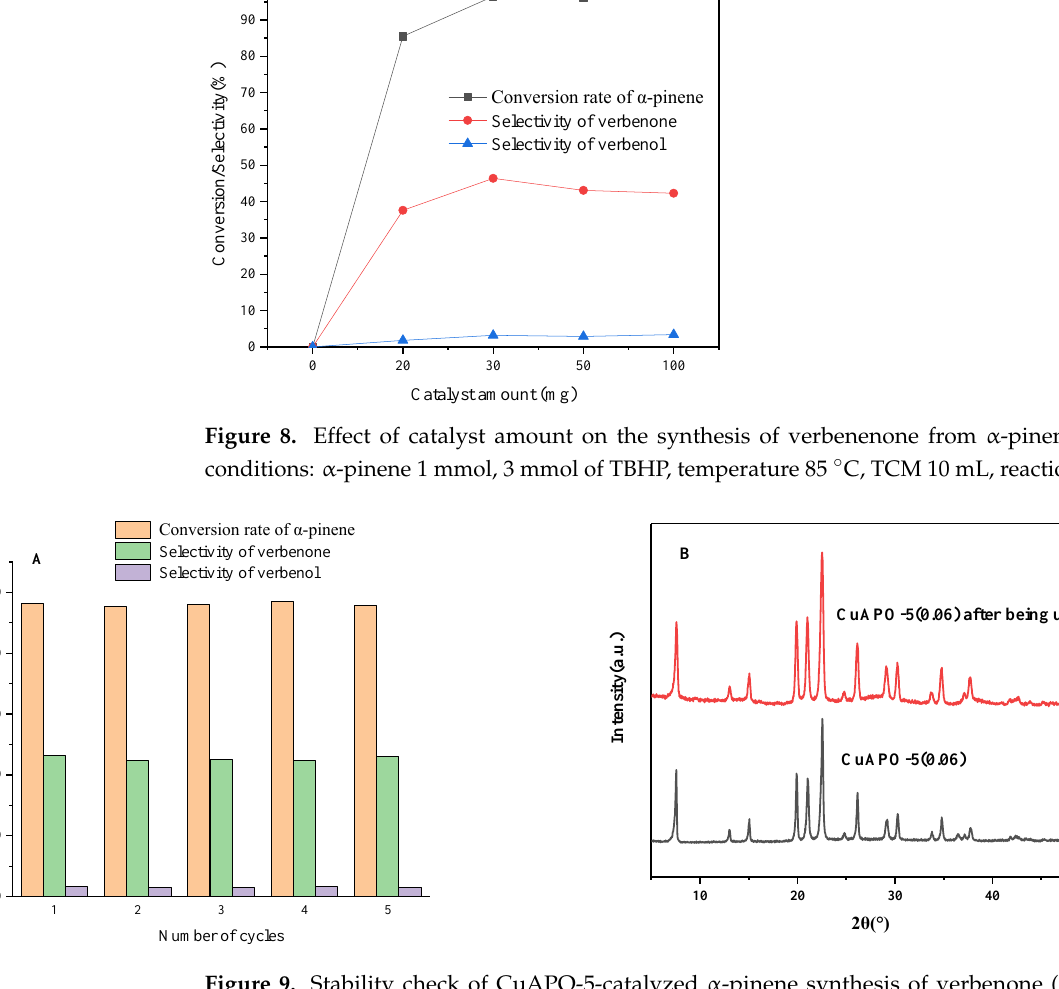
Figure 9. Stability check of CuAPO-5-catalyzed α -pinene synthesis of verbenone ( A ) and XRD spectrum of recovered CuAPO-5 ( B ).